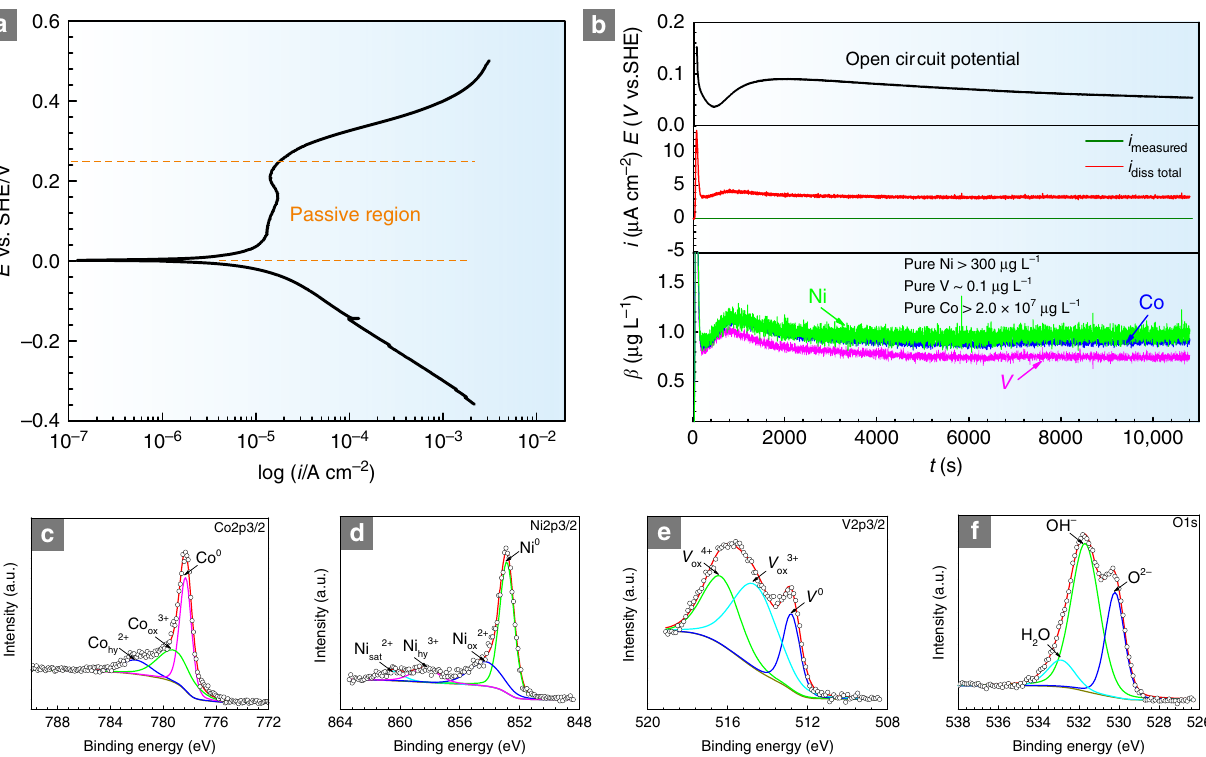
Fig. 4 Electrochemical behavior and the composition of the surface barrier fi lm. a Potentiodynamic polarization curve of MEA in 0.1 M H 2 SO 4 solution. b Online ICP-MS dissolution pro fi les were converted into dissolution concentration values of metallic-Co, Ni, and V shown in blue, green, and pink color codes, respectively. For comparison, we also measured the dissolved concentrations of Co, Ni, and V ions from their respective pure metals under the same conditions. c – f XPS spectra of Co2 p 3/2, Ni2 p 3/2, V2 p 3/2, and O1 s of the barrier fi lms formed on equiatomic CoNiV MEA in 0.1 M H 2 SO 4 dissolved concentration of V ions (~0.1 μ g L − 1 ) from pure V, the concentration of V ions (~0.8 μ g L − 1 ) dissolving from the current